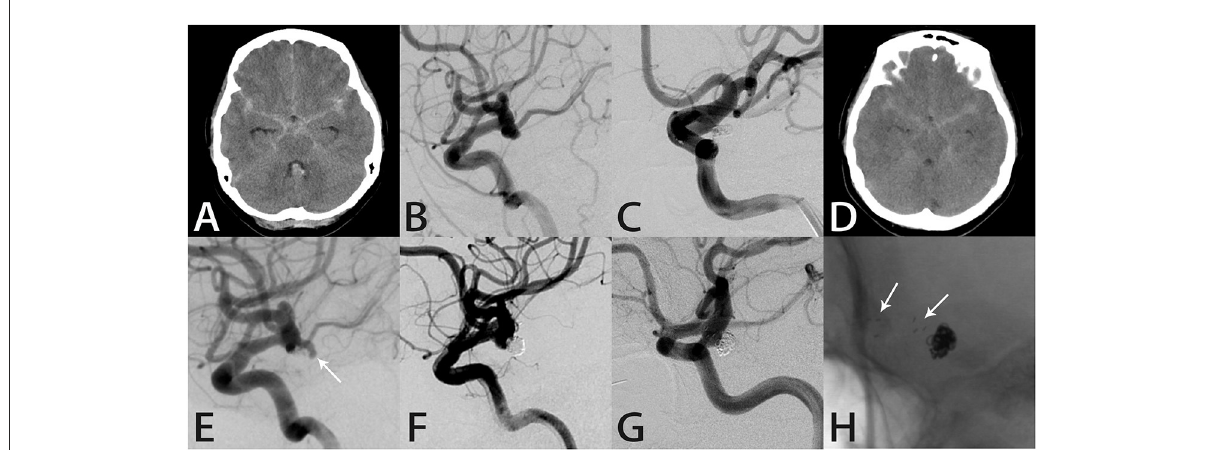
FIGURE4 Images from a 51-year-old woman with a left posterior communicating artery aneurysm (case 9). (A) Computed tomography showed subarachnoid hemorrhage in the brain basal cistern, lateral fissure cistern, longitudinal fissure cistern, and ambient cistern. (B) Angiography showed a left posterior communicating artery aneurysm. (C) The aneurysm was occluded completely after coil embolization. (D) Computed tomography showed subarachnoid hemorrhage in the lateral fissure cistern and sulcus. (E) Angiography showed recurrence of the left posterior communicating artery aneurysm. (F) Angiography immediately after re-treatment showed RR class II occlusion. (G) Follow-up angiography 12 months later showed the aneurysm remained RR class II occlusion. (H) Intraprocedural angiography showed the Atlas stent remained stable and the three radiopaque markers (white arrows) could be seen at the proximal and distal ends of the Atlas stent (3.0 × 21mm).